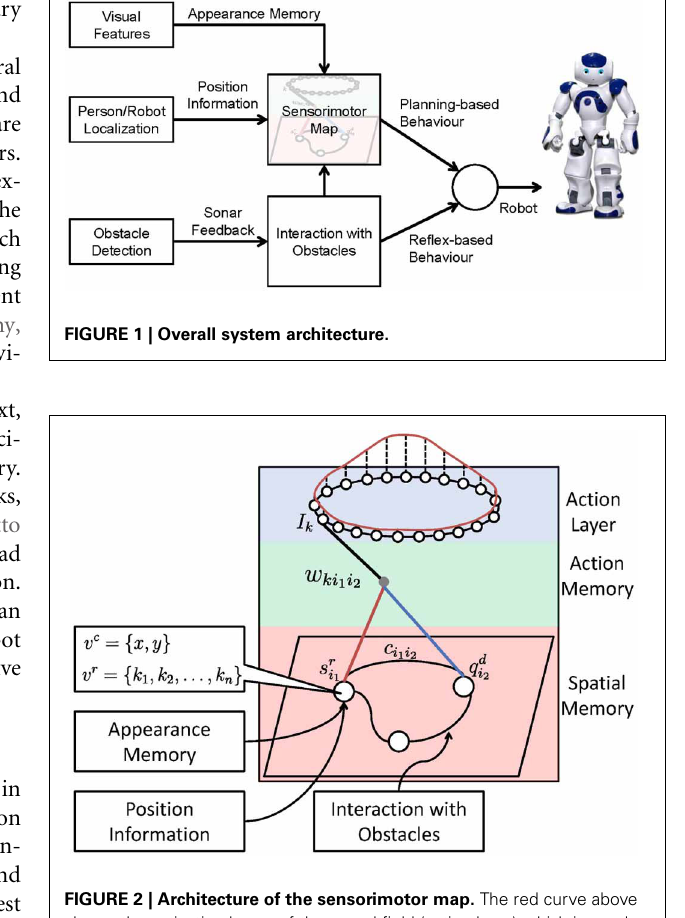
FIGURE 2 | Architecture of the sensorimotor map. The red curve above shows the activation bump of the neural field (action layer) which is used for robot